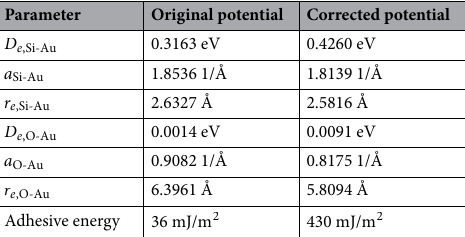
Table 1. Fitted Morse potential V ( r ) = D e ( e − interactions. Shown is the parameters for the original potential and the one with corrected adhesive energy (see Fig. 1).